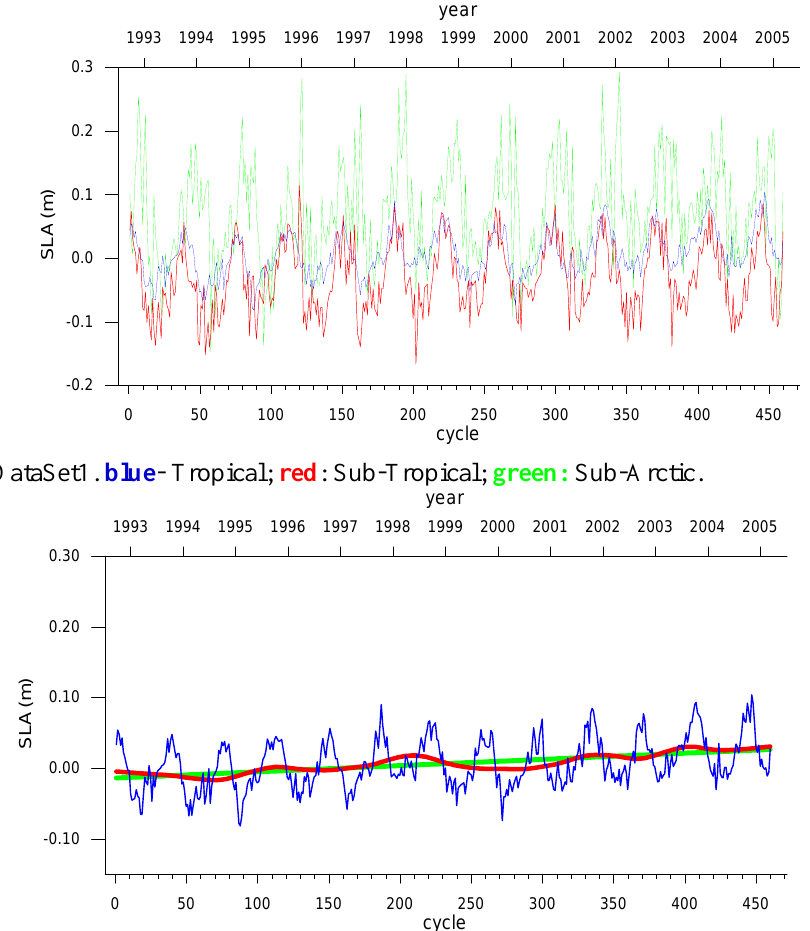
Figure 3a. Various curves for DataSet1 in the Tropical region. blue : SLA; red : interannual variations; green : linear trend.